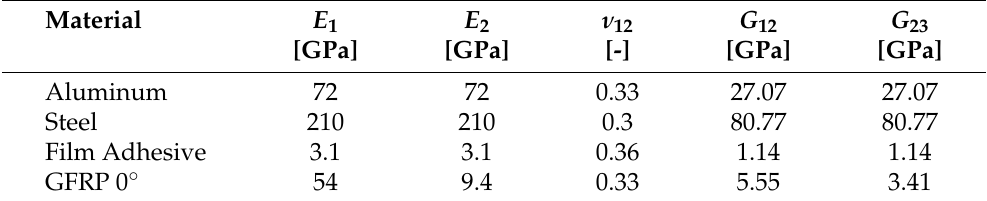
Table 2. Material properties used for the numerical simulations of the wave